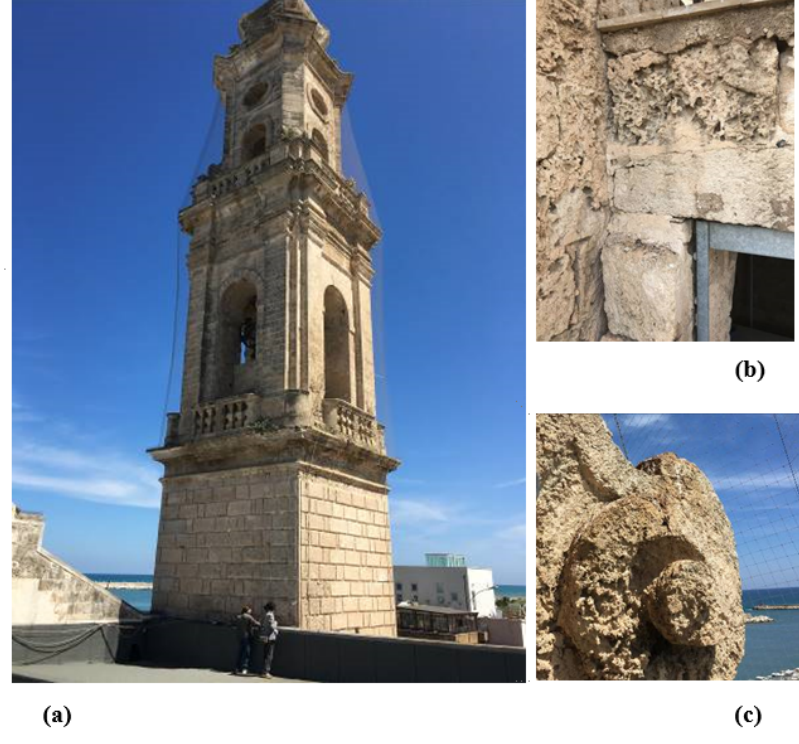
Figure 1. Belltower of Santa Maria di Loreto. Mola di Bari. ( a ) General view of the belltower. ( b ) Calcarenite stone superficially damaged by environmental effects near one of the access doors to the tower. ( c ) Ornamental element of calcarenite stone superficially damaged by environmental ef ‐ fects.